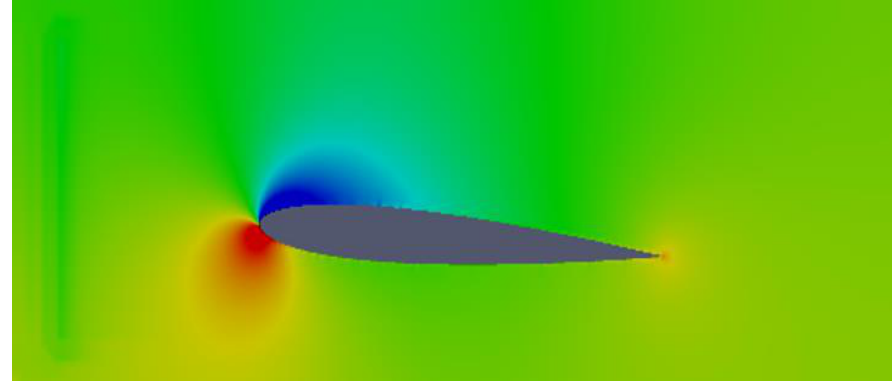
Figure 4. Pressure distribution of the flow fields.